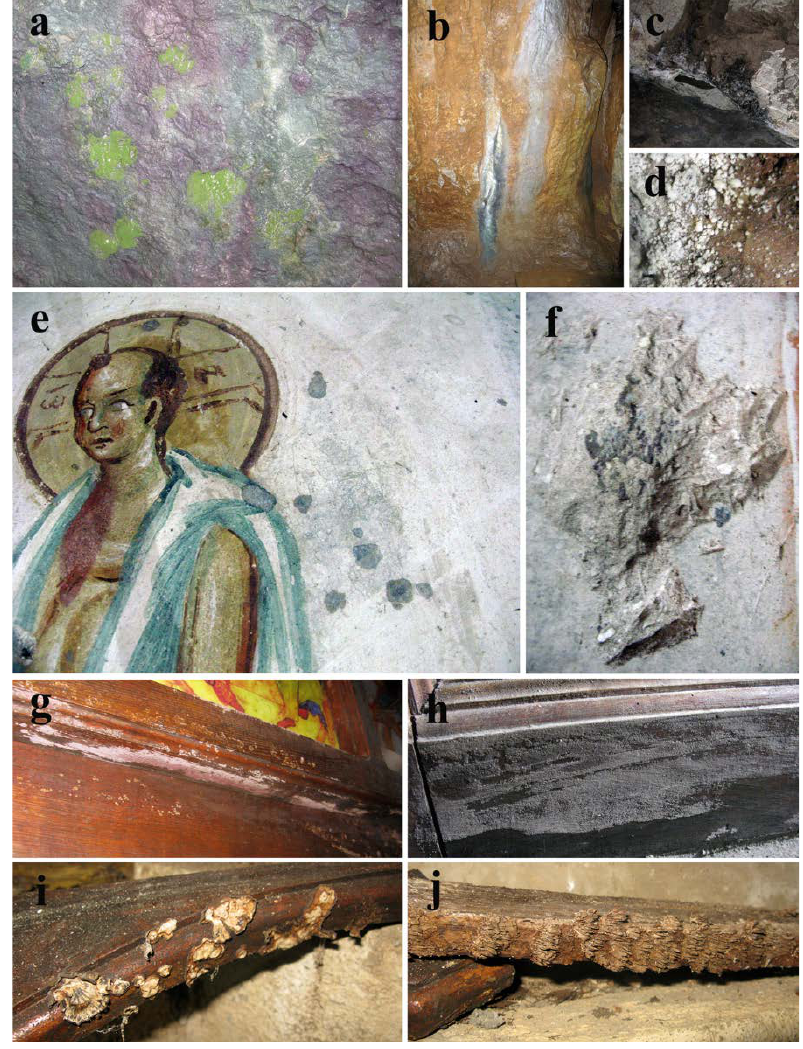
Figure 2. Alterations observed on the various substrata within the Cave Church of Sts. Peter and Paul: ( a ) green biofilm and pink patina on northern stone wall; ( b,c ) differently pigmented patinas; ( d ) surface salt efflorescence; ( e ) wet grayish surface discolorations; ( f ) loss of fresco painted layer and plaster; ( g,h ) fungal infestation on wooden iconostasis; ( i,j ) fruiting bodies of Stereum gausapatum and other wood-decay fungi on iconostasis fragments.